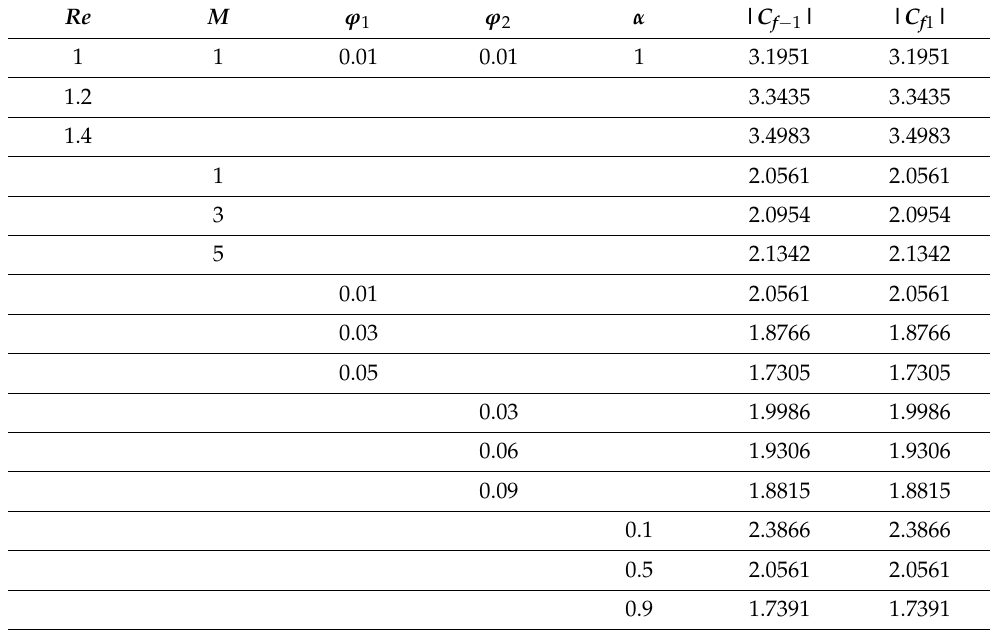
Table 3. Calculation of the effects of flow on the skin friction coefficient from upper and lower porous surfaces.